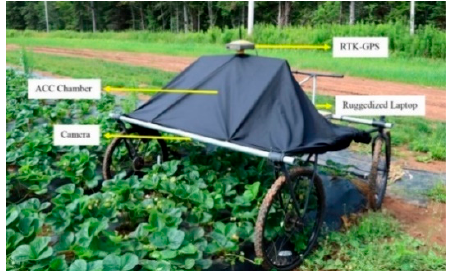
Figure 1. Mobile platform of real-time machine vision system with artificial cloud lighting condition (ACC) chamber.